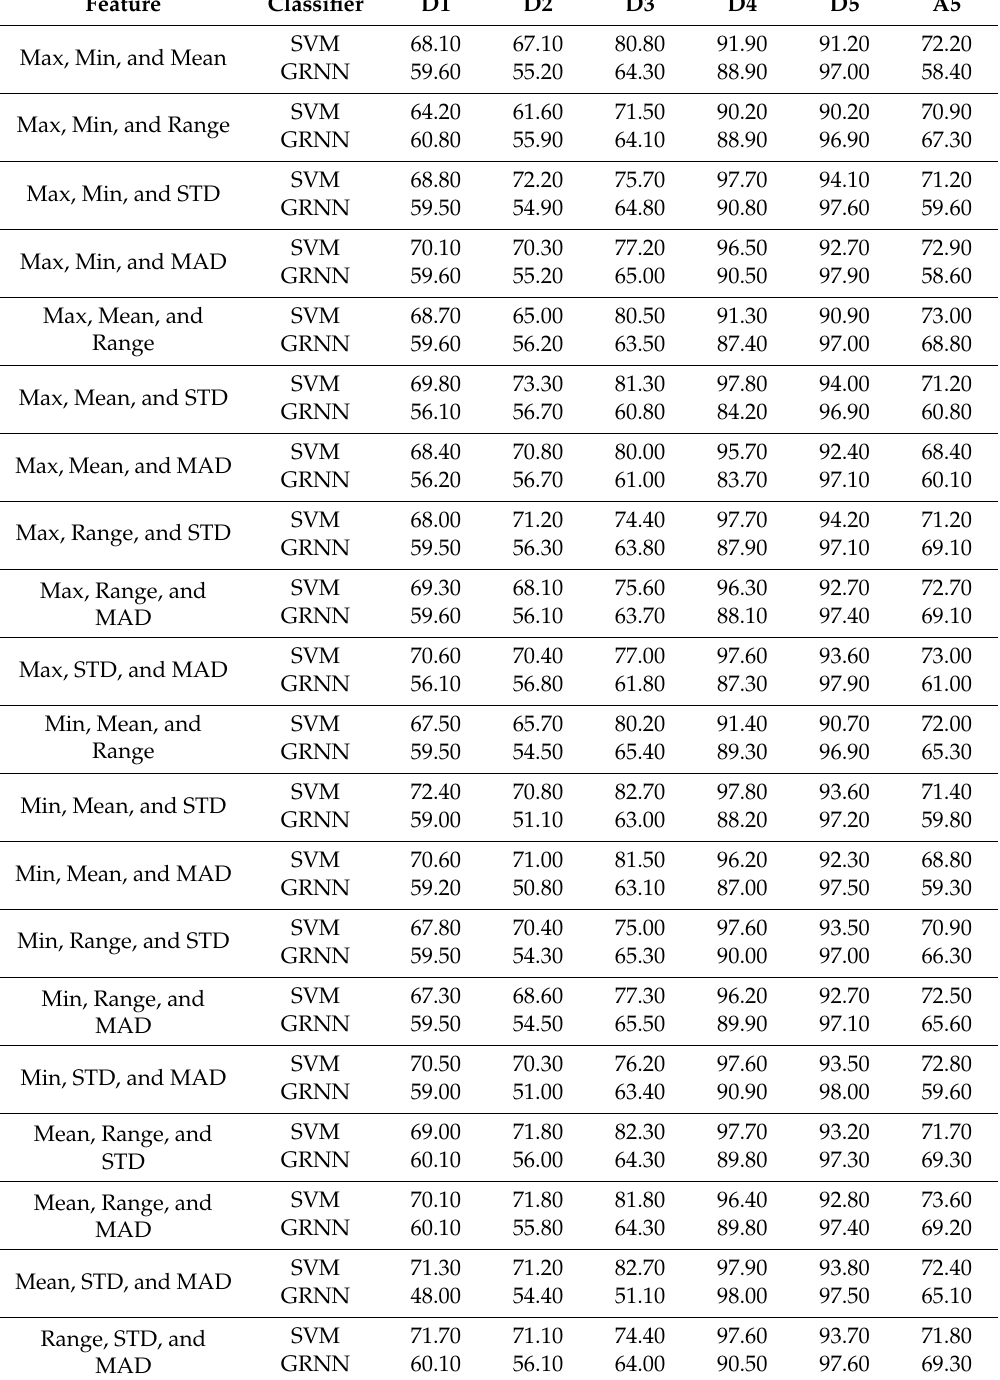
Table 3. Accuracy of three dimensions by Support Vector Machine (SVM) and Generalized Regression Neural Network